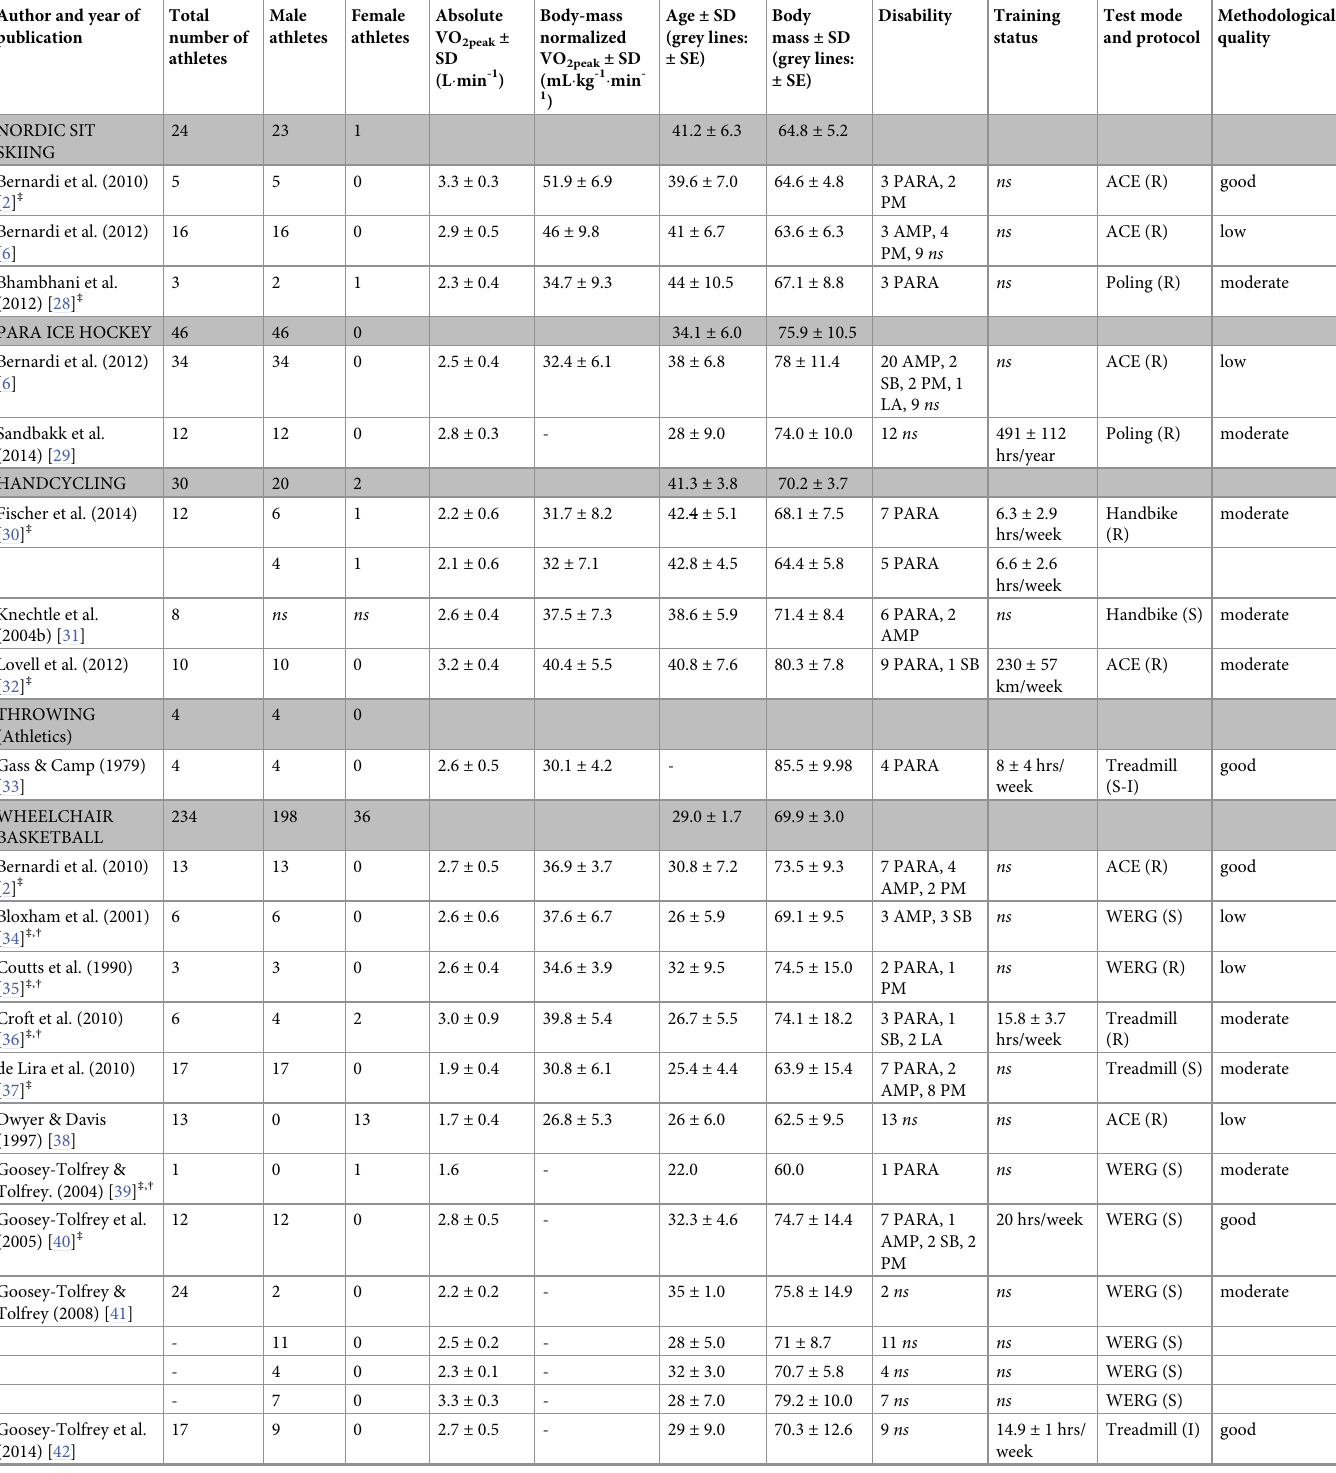
Table 3. Data extraction of number of male and female participants, absolute and body-normalized VO 2peak values, age, body mass, type of disability, training sta- tus, exercise mode, and methodological quality of each of the studies included in this systematic literature review on peak aerobic capacity between and within Para- lympic sitting sports. Mean age and body mass ± SE are presented of each sports discipline are presented in the grey